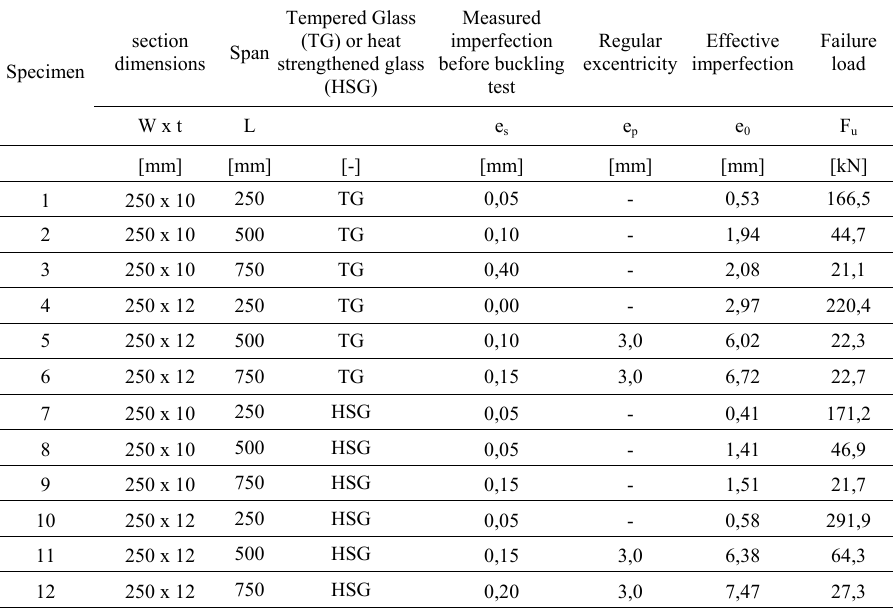
Table 1: Specimen and test results (remark: buckling length l k =l+12 mm due to test set